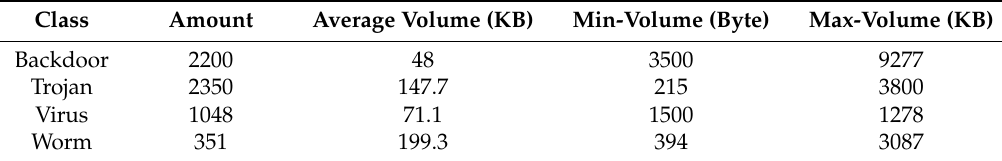
Table 1. Malware Information.